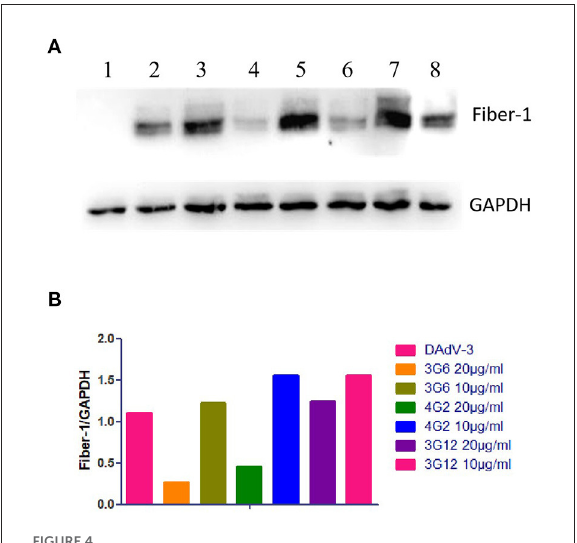
FIGURE4 Neutralization activities of mAbs 3G6 and 4G2 against DAdV-3. (A) Western blot assay for the neutralizing activity of mAbs 3G6 and 4G2. Lanes 1 and 2: The lysates of LMH cells infected without or with DAdV-3. Lane 3 and 4: The lysates of the infected LMH cells treated with 10 and 20 µ g/ml of mAb 3G6, respectively. Lane 5 and 6: The lysates of the infected LMH cells treated with 10 and 20 µ g/ml of mAb 4G2, respectively. Lane 7 and 8: The lysates of the infected LMH cells treated with 10 and 20 µ g/ml of the control mAb 3G12, respectively. (B) Analysis of the rate of the expressed level of Fiber-1 and GAPDH in the neutralizing